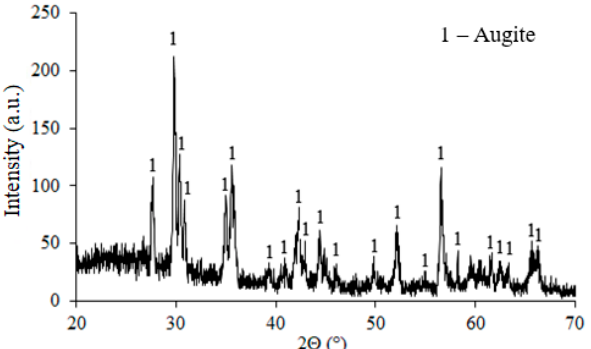
Figure 7. X-ray diffraction patterns of augite.